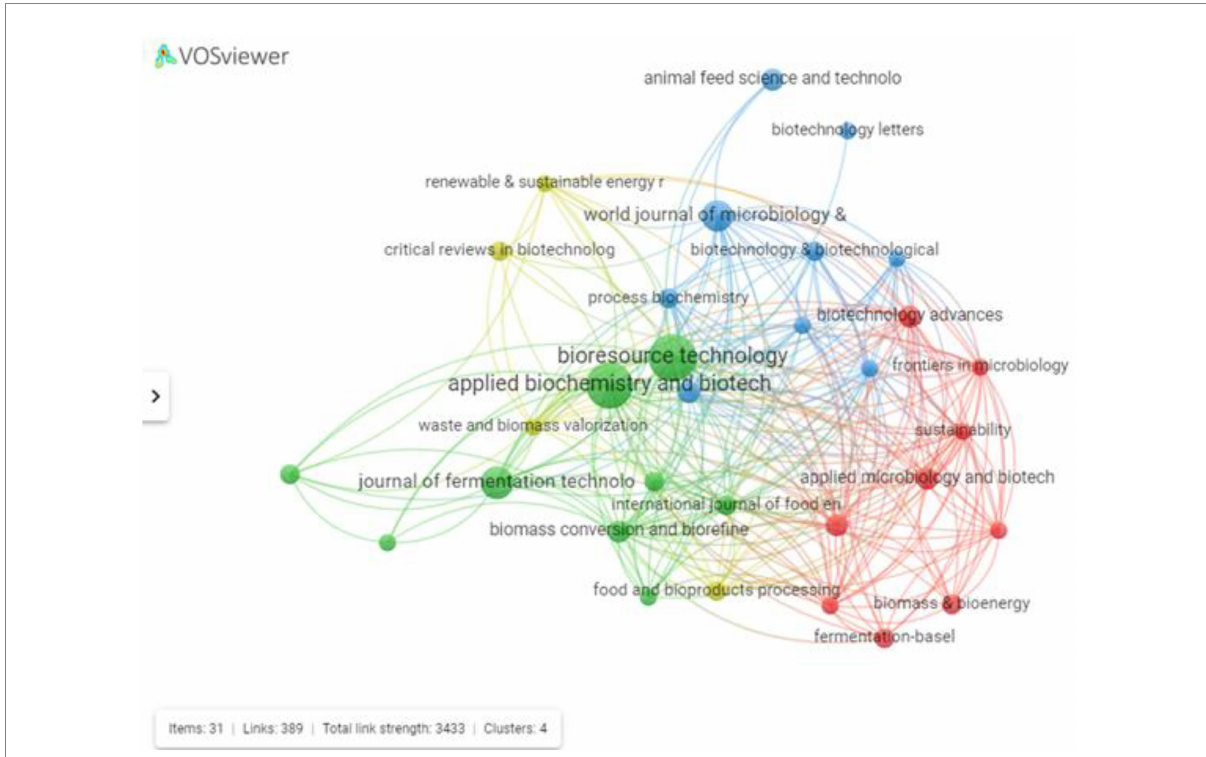
FIGURE 6 Network map with the main journals with publications using the keywords and Boolean operators “fermentation” and “single cell protein” or “single-cell